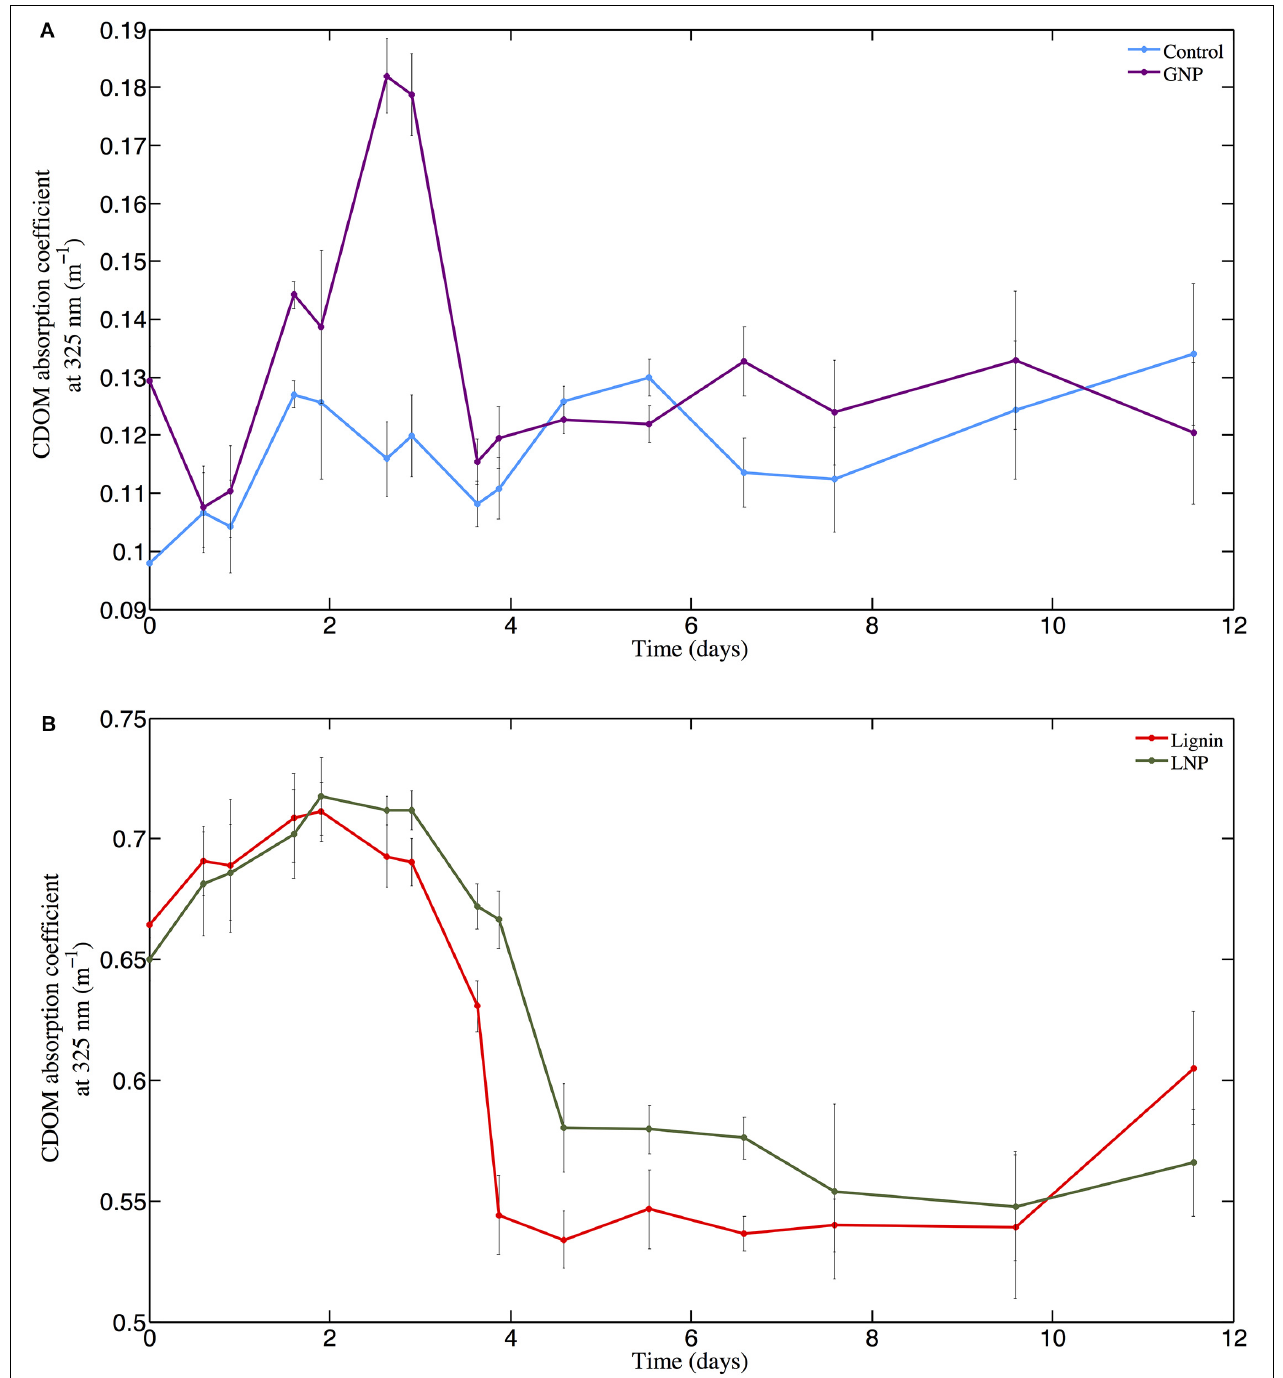
FIGURE 2 | Changes in the CDOM absorption coefficient (m – 1 ) at 325 nm from day 0 through day 12 ( T 0 – T 15 ) for (A) GNP (purple line with dots) and Control (light blue line with dots) and (B) Lignin and LNP treatments (red line and green line with dots, respectively).